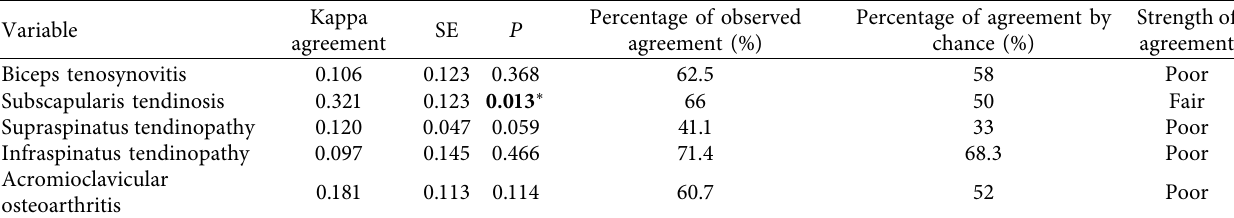
Table 4: Agreement between clinical examination and ultrasound in detecting shoulder pathologies in the study HD patients ( n � 56 shoulders).